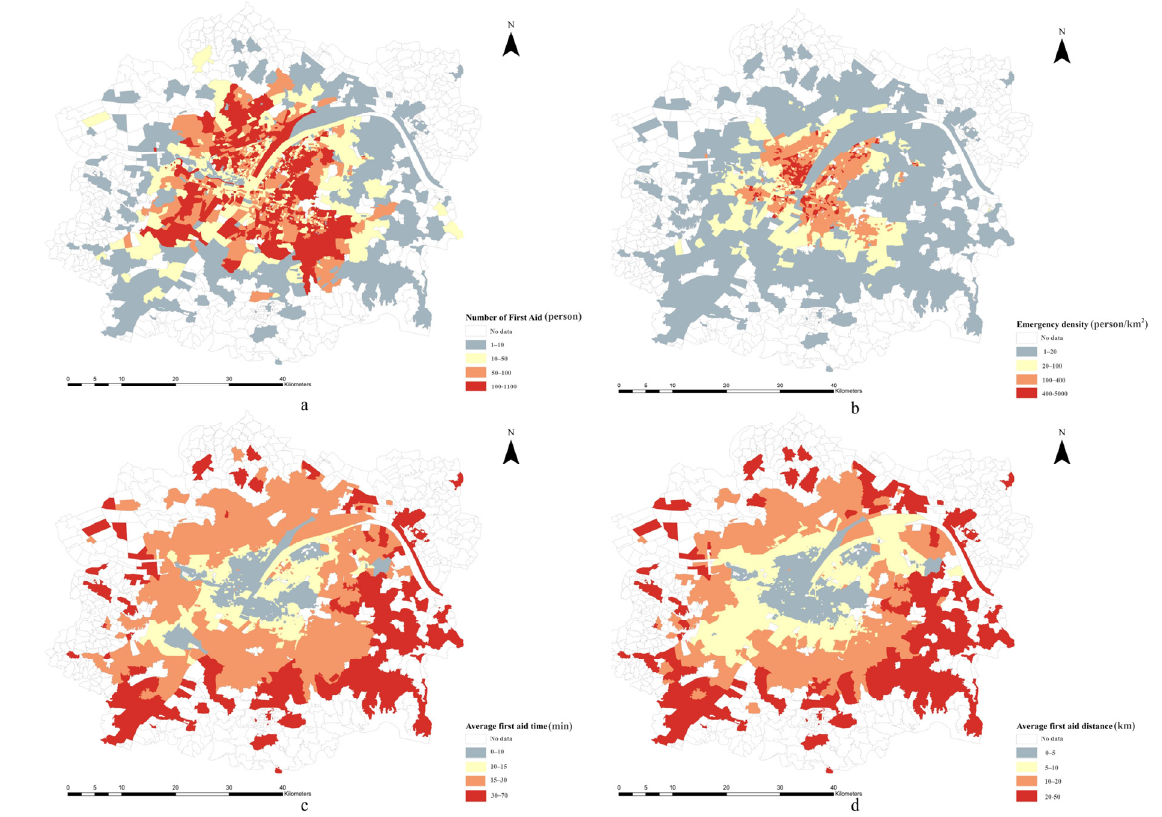
Figure 3. First aid incident numbers among communities ( a ), community densities ( b ), average first aid times ( c ), and average first aid distances ( d ).